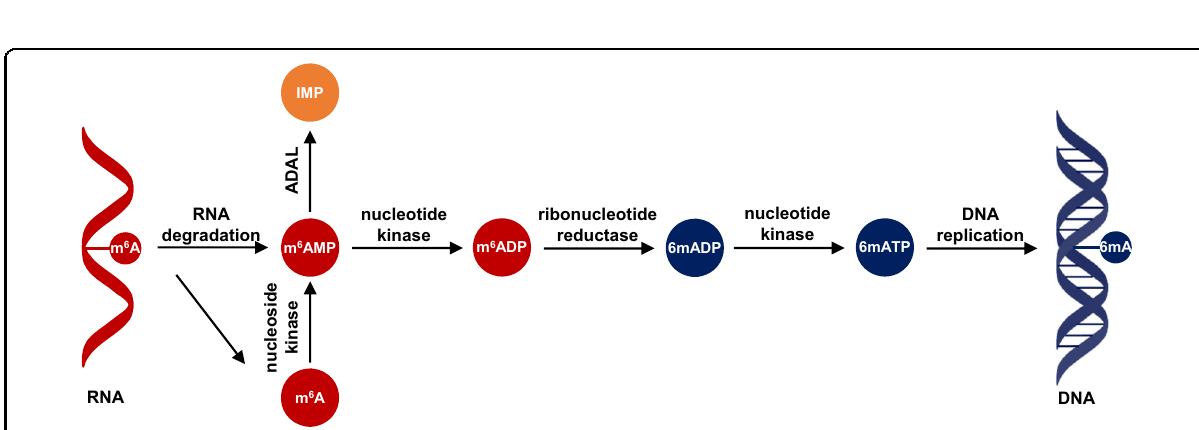
Fig. 7 The proposed pathway for the misincorporation of DNA 6mA. Misincorporated DNA 6mA is associated with RNA m 6 A decay and purine salvage synthesis